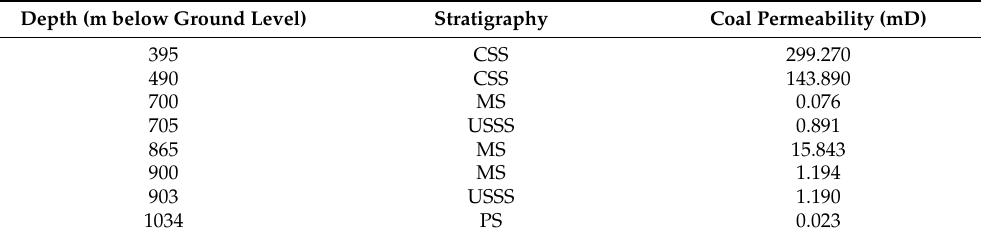
Table 3. Coal permeability in the southern USCB. Laboratory measurements on samples taken from various locations [15,51], CSS—Krakow Sandstone Series, MS—Mudstone series, USSS—Upper Silesian Sandstones Series, PS—Paralic